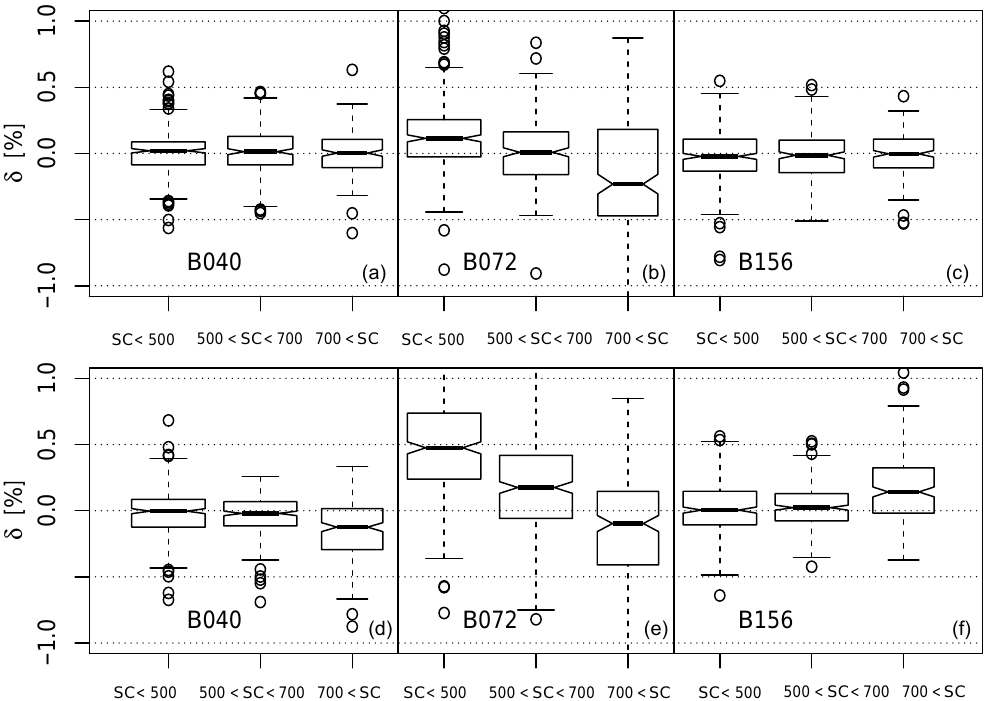
Figure 8. Box plot of the δ time series of the three Brewer instruments according to three classes for the median of the ozone slant column monthly distributions (red lines in Fig. 7): median SC ≤ 500, 500 < median SC ≤ 700 and 700 < median SC. The upper panel is for the Arosa period, the lower panel for the Davos period and from left to right, the distributions of δ B